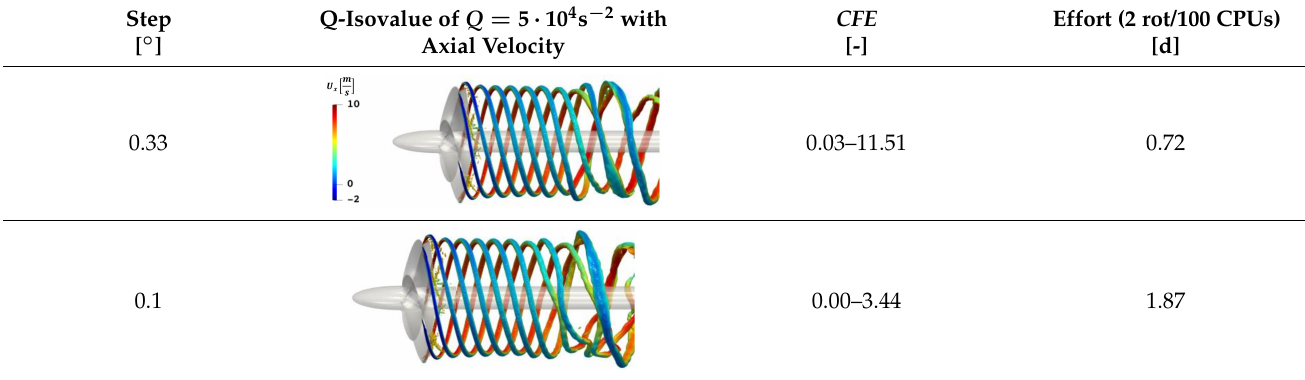
Table 4. Newcastle. Effect of different time steps on the propeller slipstream vorticity with ILES for Newcastle